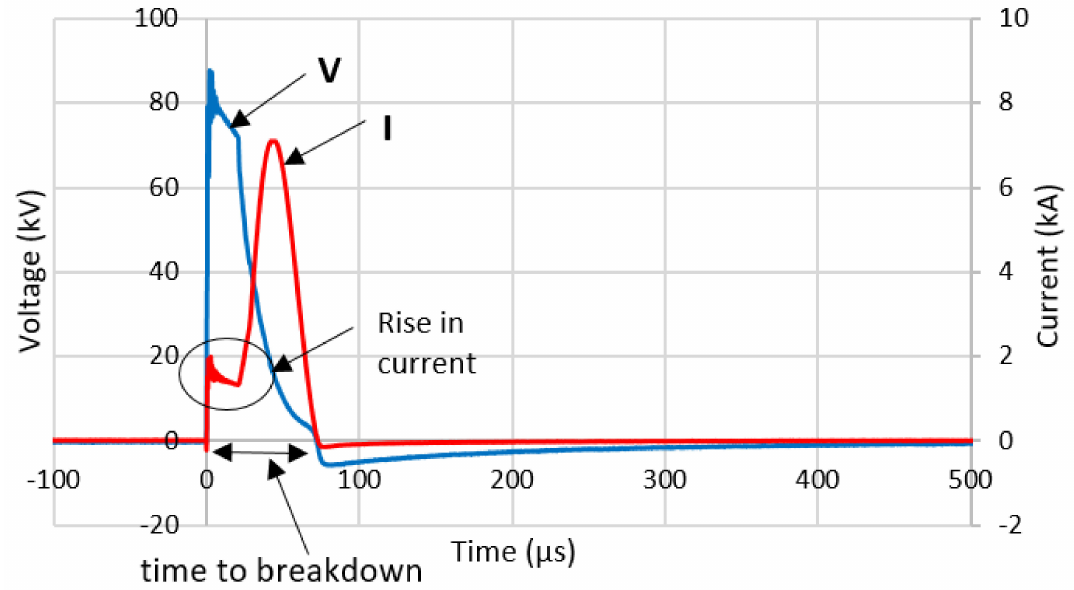
Figure 9. Voltage and current traces during breakdown in GE 5, at charging voltage of 120